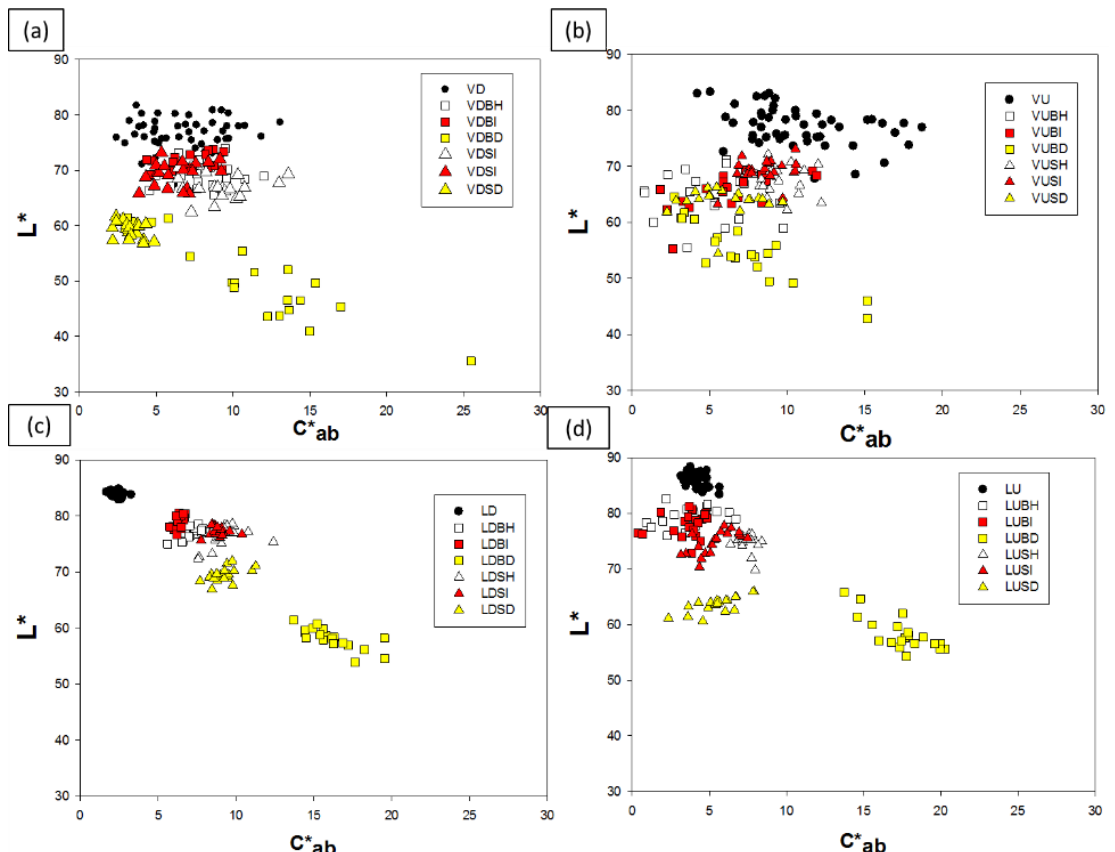
Figure 6. L *– C * ab graphs representing color data for the original surfaces and after cleaning of the blue and silver graffiti paints on Vilachán granite ( a , b ) and Lioz limestone ( c , d ). ( a , c ): Cleaned disc-cutting surfaces. ( b , d ): Cleaned bush-hammering surfaces. See Table 1 for samples’ nomenclature and for interpretation of the references to color in this figure legend.